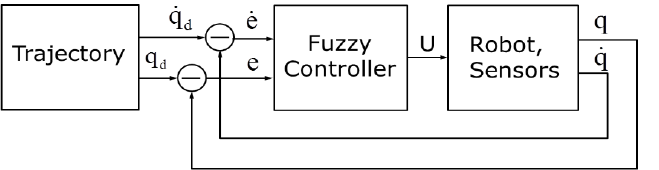
Figure 11. The general structure of a control system for a bipedal robot, in which the control block is a fuzzy controller.